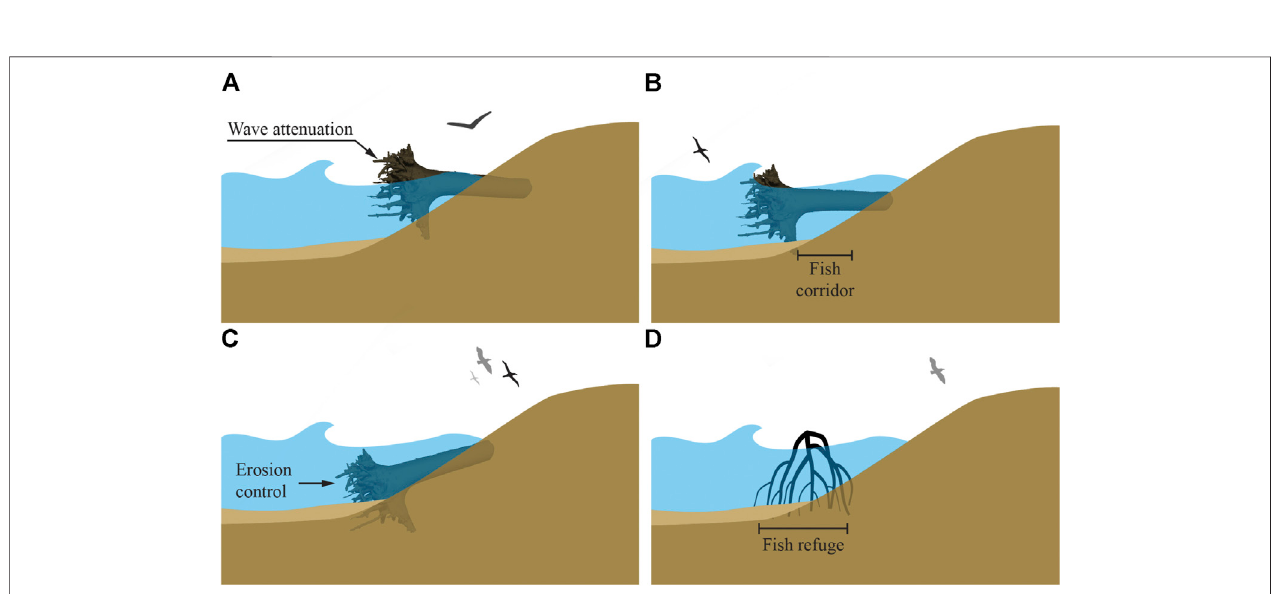
FIGURE 12 | Multifunctional revetment concept designs — (A) — A modeled rootwad illustrating wave attenuation with the root fan facing seaward, and the trunk endembeddedalongtheslopedshorelineface. (B) — Spacingbetweentherootfanandslopedshorelinefaceshowspossiblepassagefora fi shcorridor. (C) — Arootfan embedded more in the sediment bottom may provide greater toe protection of a steeper shoreline face. (D) — Amangrove like structure can attenuate waves in addition to providing habitat ( fi sh refuge) through spacing control.